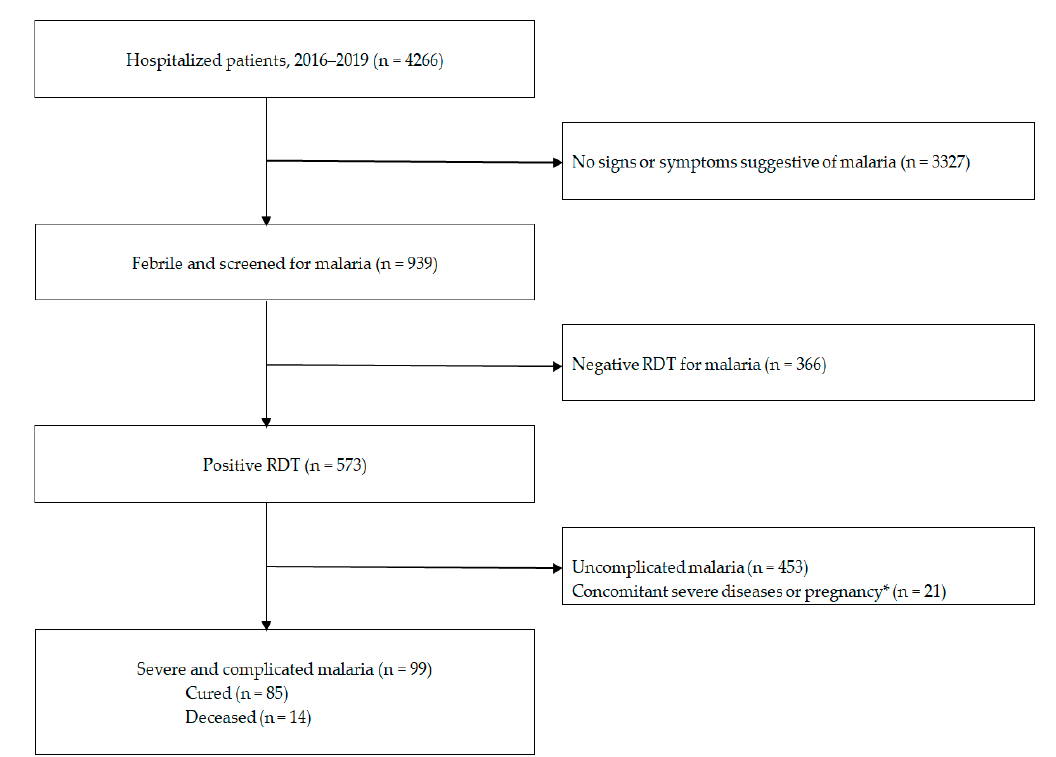
Figure 2. Flow chart of patient recruitment in Kiffa Regional Hospital, southern Mauritania. * These malaria-infected patients also had severe chronic cardiac, renal, or hepatic diseases or human immunodeficiency virus/acquired immunodeficiency syndrome (n = 17) or were pregnant (n = 4). RDT, rapid diagnostic test for malaria.